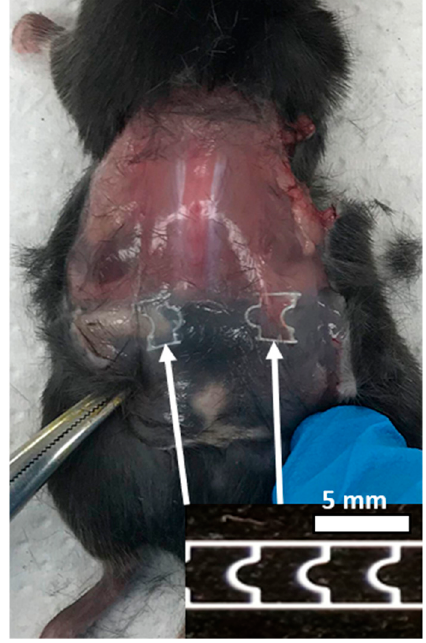
Figure 7. Segments of ribbons made of photo-chemically etched, uncoated Zn (shown) or AZ31 Mg were implanted subcutaneously in mice. The insert shows the original ribbon.